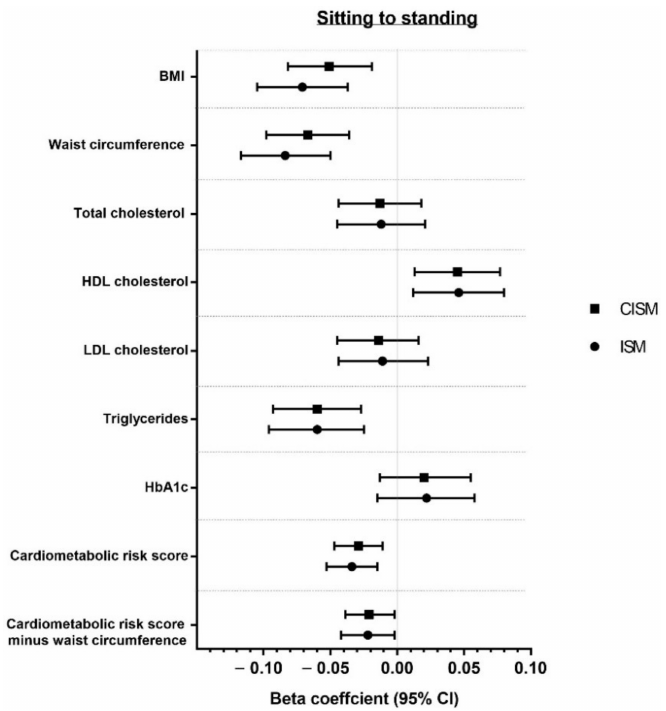
Figure 2. Reallocation of 60 min from sitting to standing.